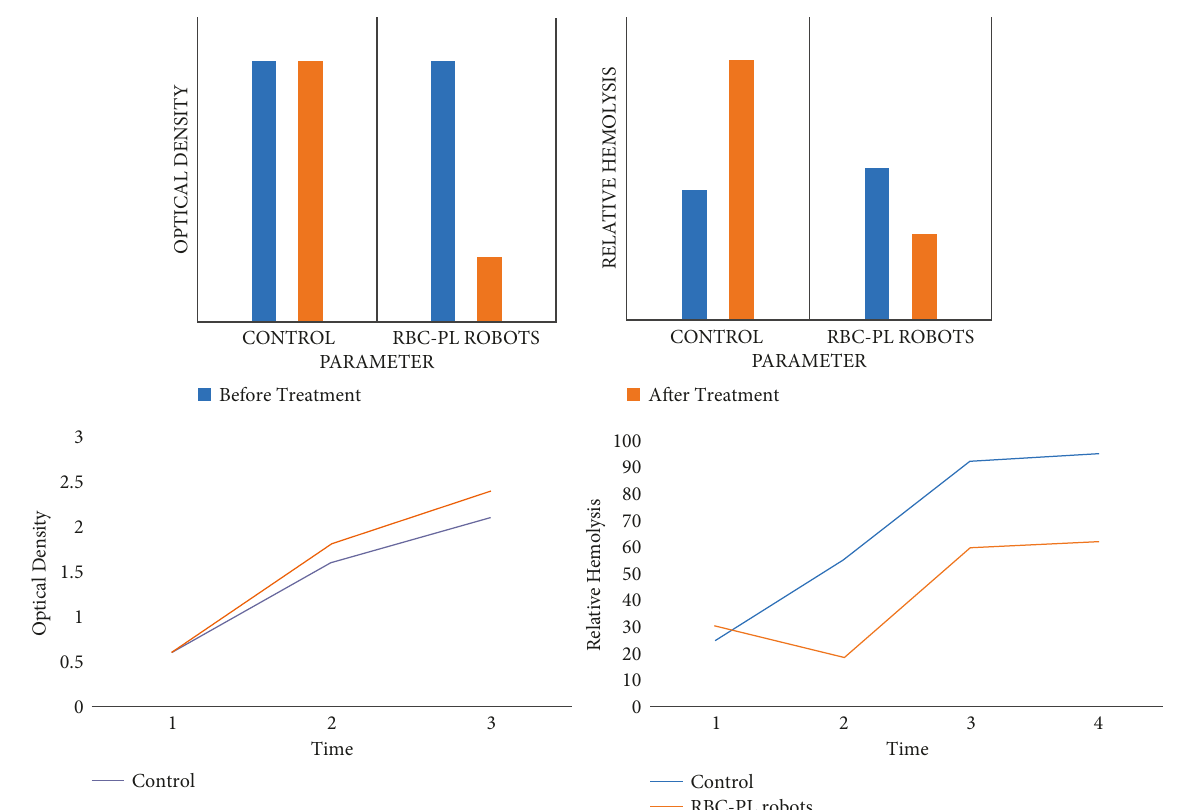
Figure 9: MRSA microorganisms and MRSA-secreting PFTs are removed in the presence of